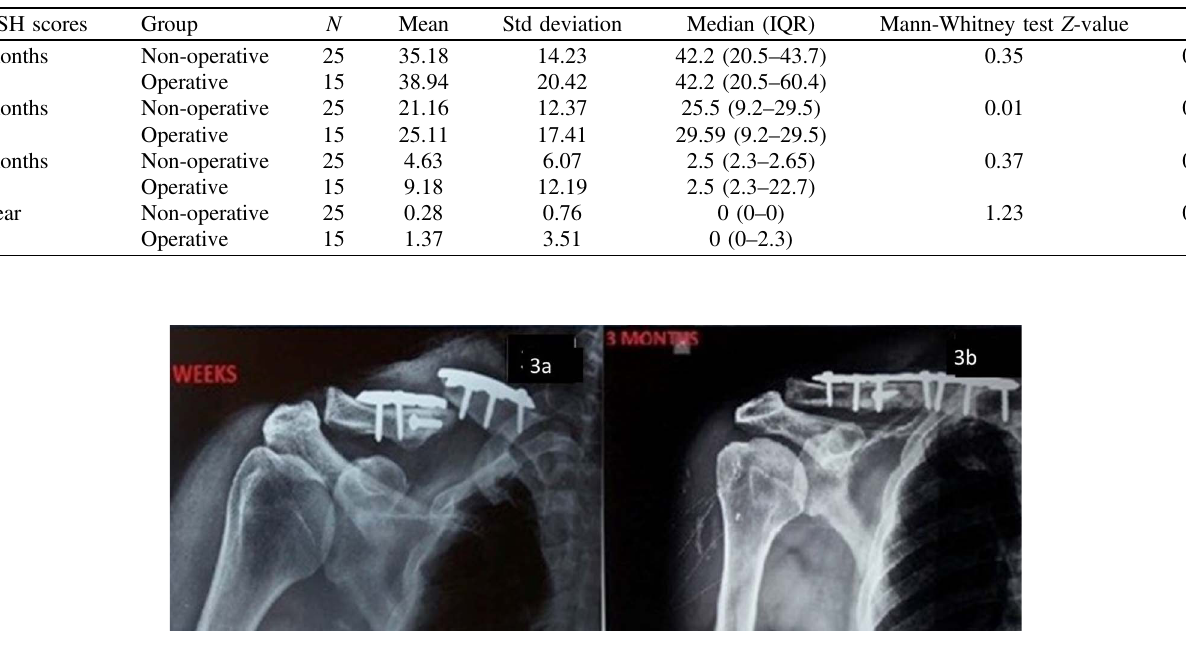
Table 4. Average DASH scores at each follow-up.